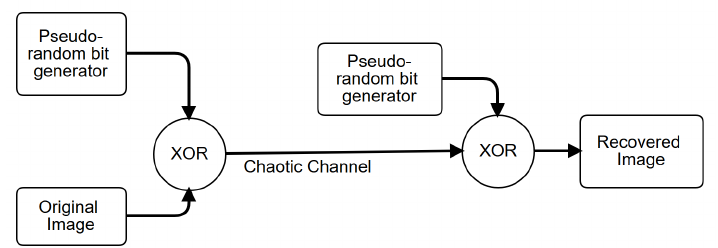
Figure 11. General description of a chaotic secure communication scheme for image encryption based on pseudorandom number generators (PRNGs) implemented by the Hopfield and Hindmarsh–Rose neural networks.